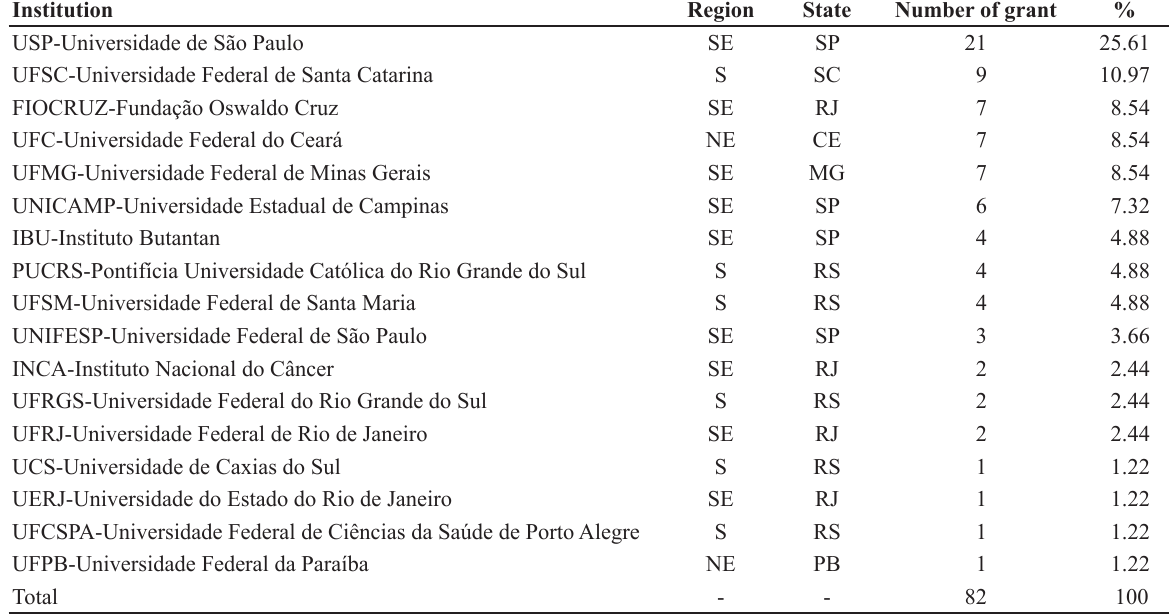
Distribution by institution, region and state of CNPq research grant (PQ 1A-D) in